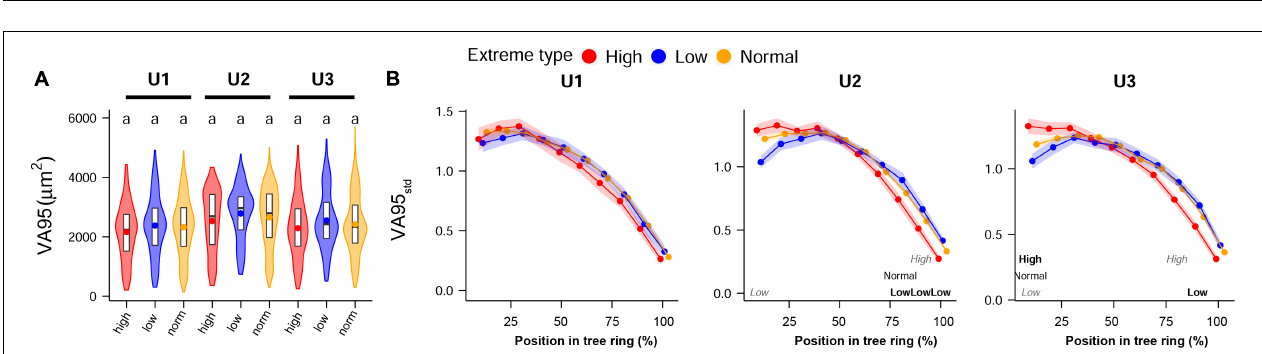
FIGURE 6 | The Spearmans’ correlation of the tree-ring sector indexed series of VA95, DH, and TRW with monthly (A) temperature and (B) precipitation at the three study sites: U1—1,200 m a.s.l.; U2—1,600 m a.s.l.; U3—1,950 m a.s.l. As an annual value, TRW has not been divided into five sectors. Colors represent the correlation coefficient values (r). Only significant correlations ( P -value < 0.05) are presented. Lower case letters indicate the initials of the previous-year’s months, while capital letters indicate the initials of the current year’s months. For the anatomical trait abbreviations, see Figure 2 .